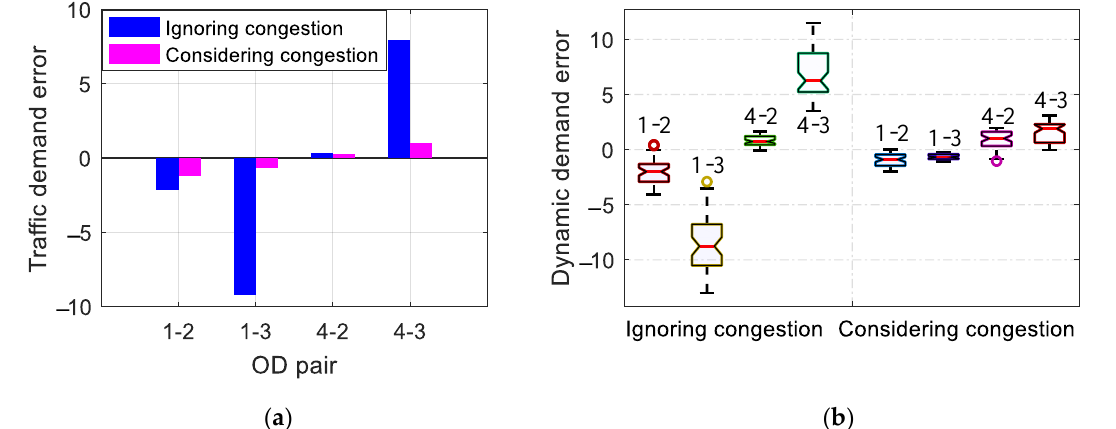
Figure 4. Comparison of traffic demand estimation errors when traffic congestion is and is not considered. ( a ) Traffic demand errors in the 30th time window. ( b ) Probability distribution of traffic demand errors in all time periods.